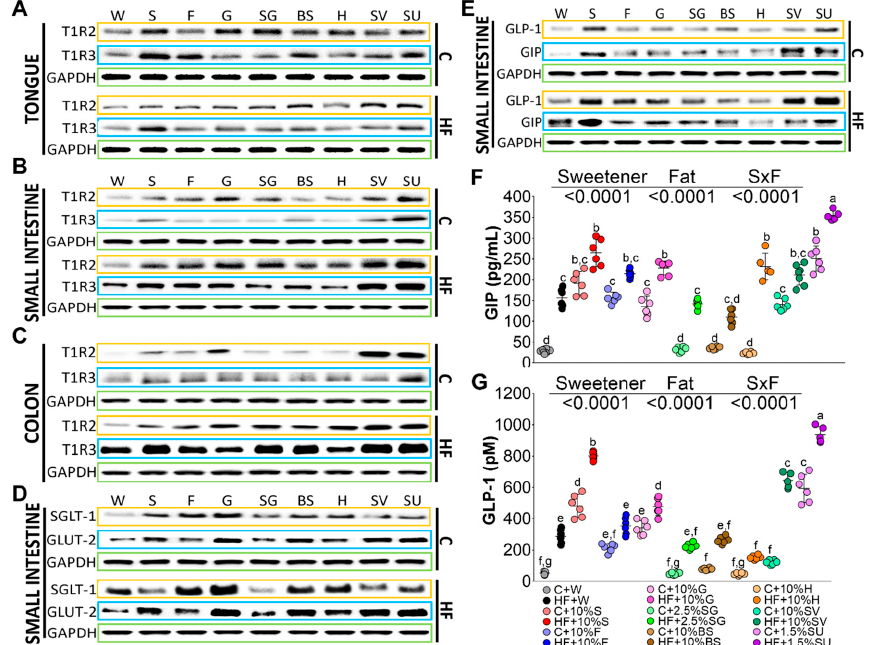
Figure 1. Taste receptors TIR2 and T1R3 in tongue ( A ), small intestine ( B ) and colon ( C ); glucose transporters ( D ) and incretins ( E ) in small intestine. Serum levels of glucose insulinotropic peptide (GIP) ( F ) and glucagon like peptide (GLP-1) ( G ) of rats fed with different sweeteners with or without high fat